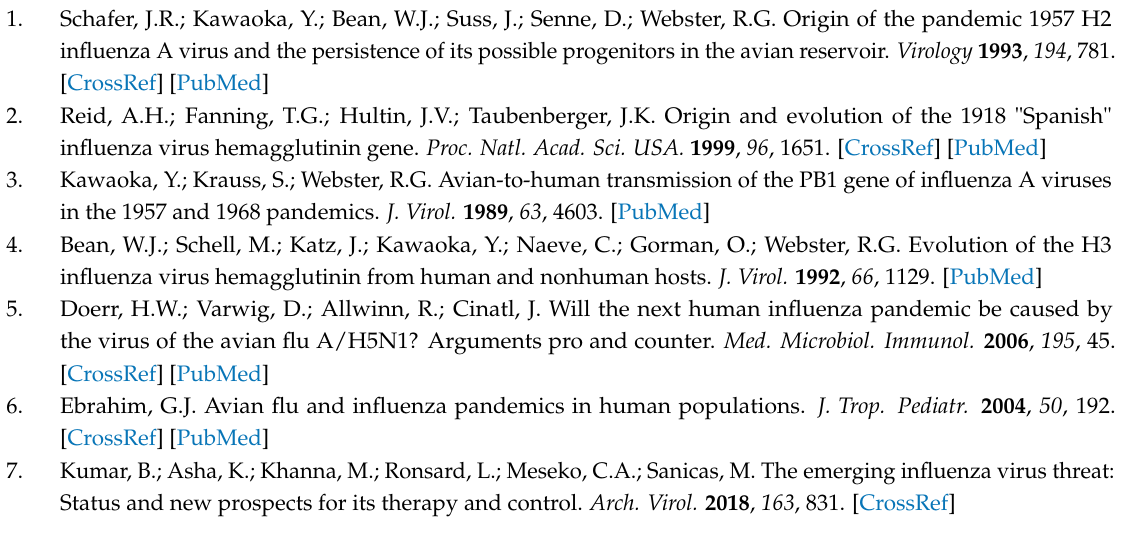
Table S1: Distribution of MCSS minima of functional groups on the binding surface of AbHC19, Table S2: Distribution of MCSS minima of functional groups on the binding surface of AbCR9114, Table S3: Distribution of MCSS minima of functional groups on the binding surface of AbBH151, Table S4: Distribution of MCSS minima of functional groups on the binding surface of